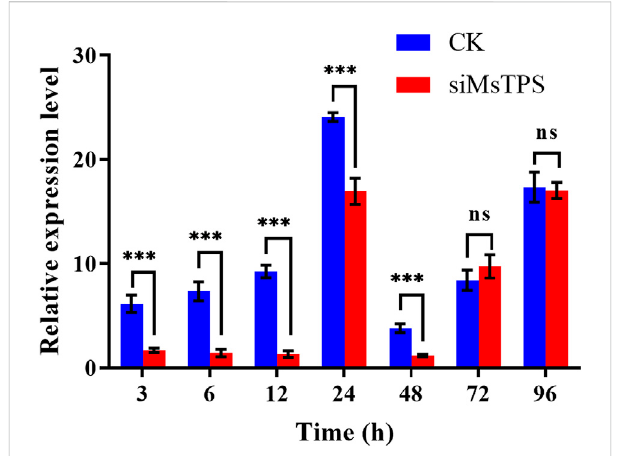
Expression of MsTPS at different post-RNAi time-points. The relative MsTPS expression levels were determined by qRT-PCR and the 2 − ΔΔ CT data analysis method. The expression data are provided as